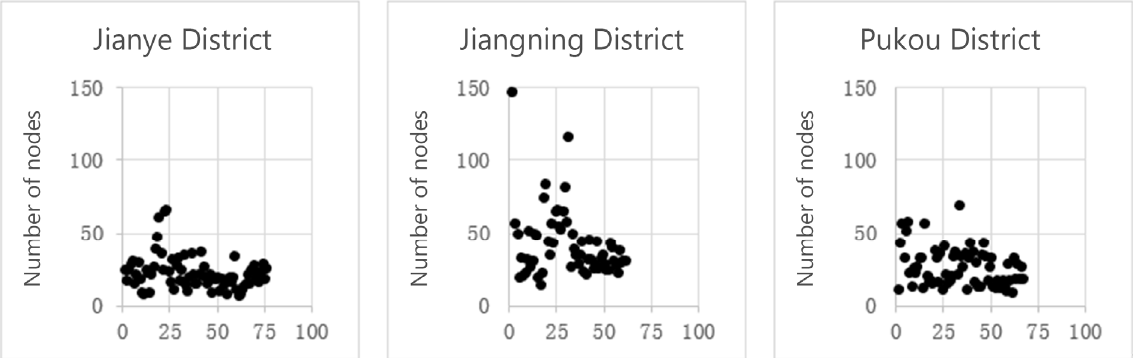
Figure 10. The number of nodes of the residential areas in Jiangning, Jianye, and Pukou District. Table 6. The number of nodes of the residential areas in Jiangning, Jianye, and Pukou District. Number of Residential Areas